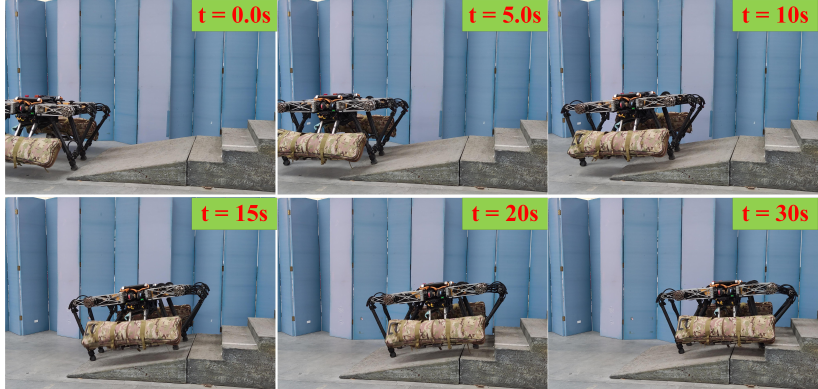
Figure 11. Snapshots of the slight slope